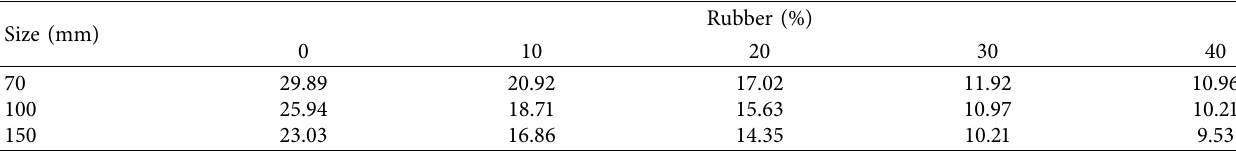
Figure 14: Failure modes of rubber concrete with different substitution rates under compression size effect ((1)70mm × 70mm × 70mm, (2) 100mm × 100mm × 100mm, and (3)150mm × 150mm × 150mm). (a) Rubber particles 0%, (b) rubber particles 20%, and (c) rubber particles 40%. Table 2: Strength eigenvalues of rubber concrete